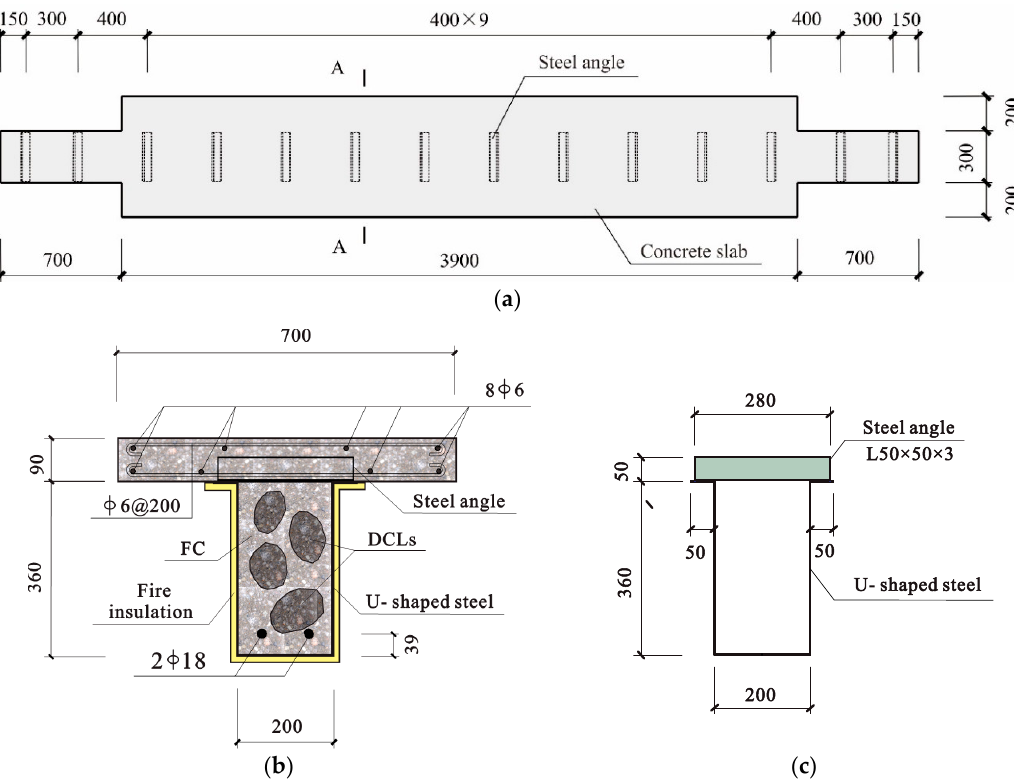
Figure 2. Schematic diagrams of specimens (unit: mm): ( a ) top view, ( b ) A-A section, and ( c ) U-shaped steel and steel angle.